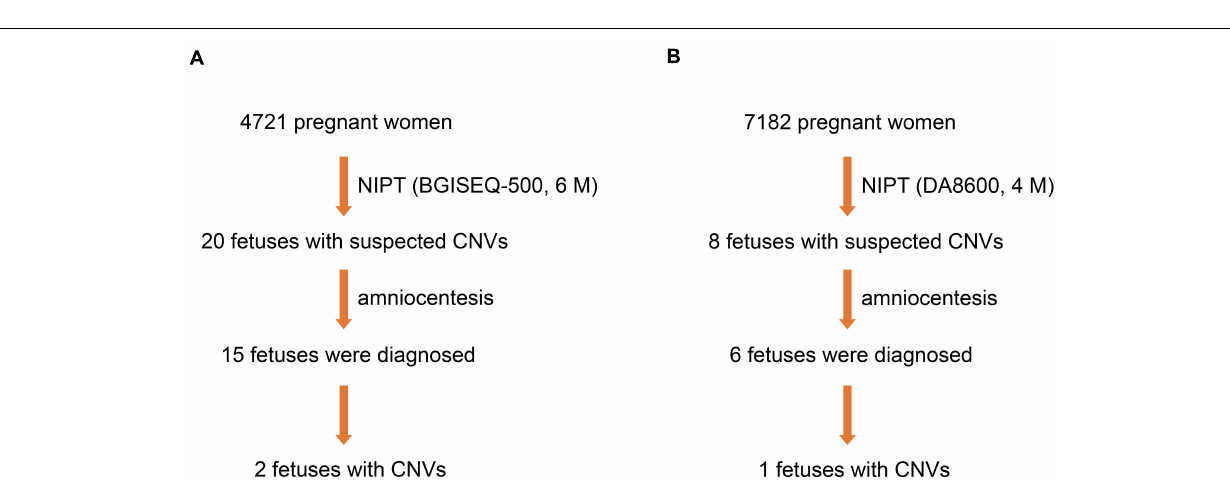
FIGURE 2 | Three fetuses diagnosed with MMS. (A) Two fetuses were diagnosed by NIPT based on the BGISEQ-500 sequencing platform with a read depth of 6 M and subsequent amniocentesis. (B) One fetus was diagnosed by NIPT based on the DA8600 sequencing platform with a read depth of 4 M and subsequent